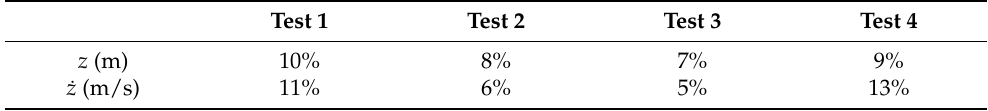
Table 2. Average NRMSE for the different wave states with D =